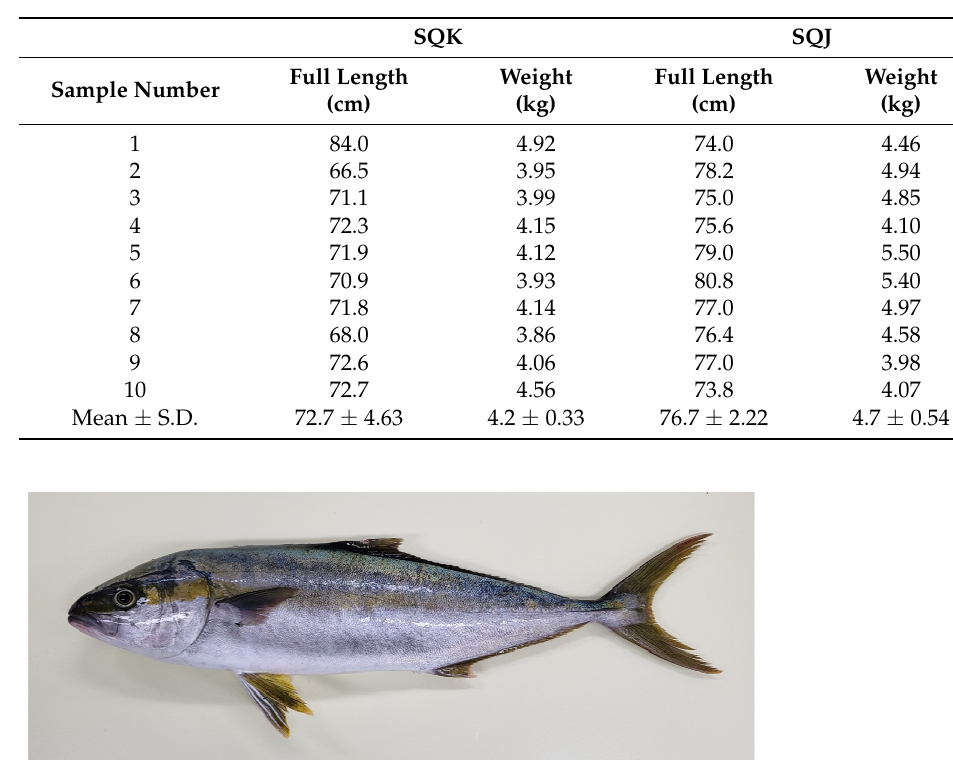
Table 2. The sample information.